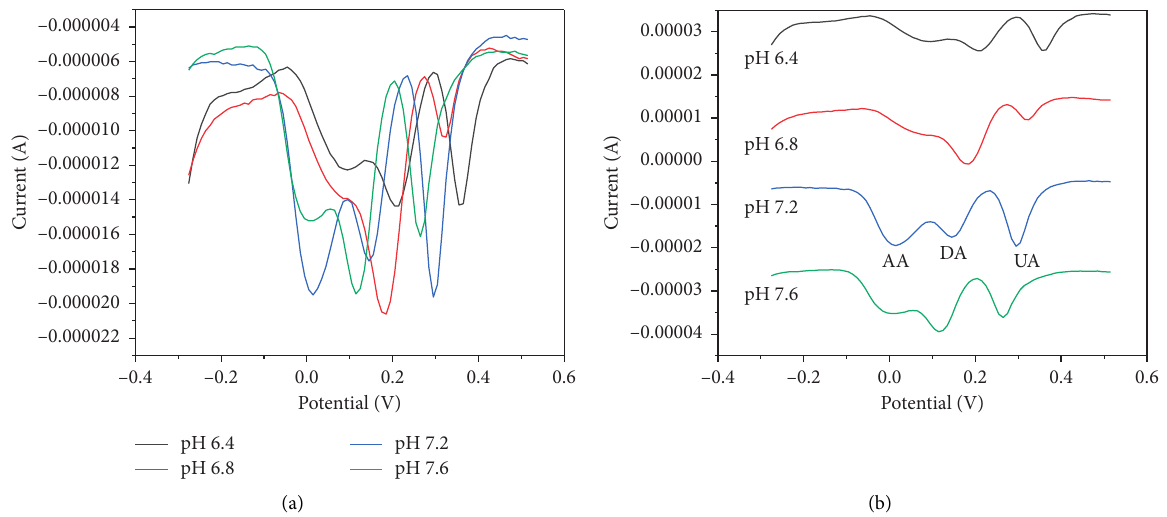
Figure 2: (a) DPVs of 0.75mM AA, 30 μ M DA, and 1.25mM UA at PdNPs/rGO/GCE at various pH values (black: 6.4; red: 6.8; blue: 7.2; green: 7.6); (b) DPV curves after